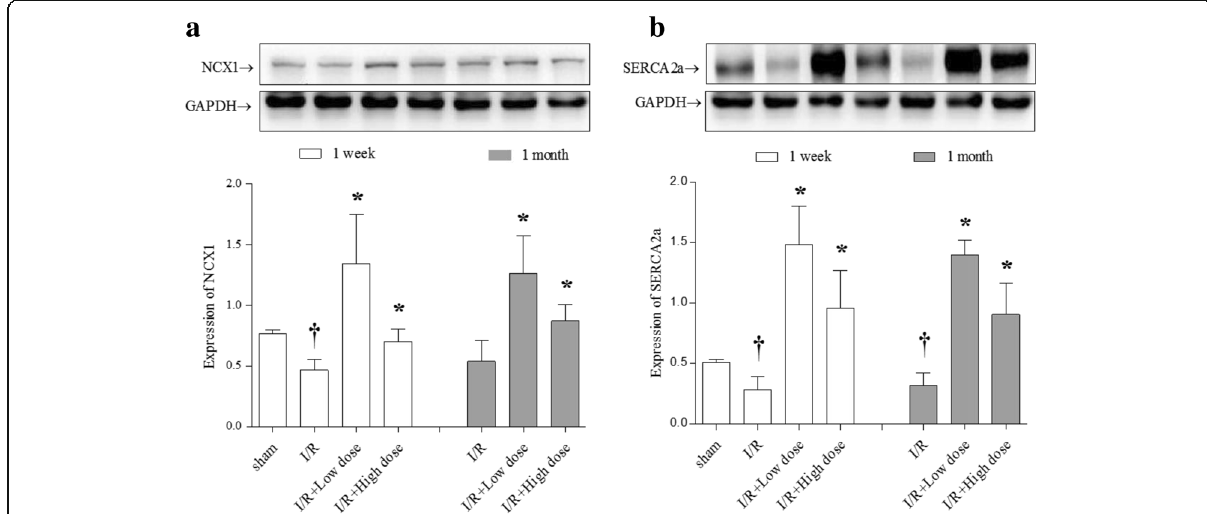
Fig. 3 Effects of MYQ on the expression of NCX1 and SERCA2a. a Expression of SERCA2a, upper is the representative blots of NCX1 and GAPDH; lower is the densitometric analysis of NCX1 expression normalized to GAPDH ( n = 8). b Expression of SERCA2a, upper is the representative blots of SERCA2a and GAPDH; lower is the densitometric analysis of SERCA2a expression normalized to GAPDH ( n = 8). Sham: Sham group; I/R: ischemic/reperfusion group. I/R + Low dose: Low dose (1 ml, P.O. tid for one-week or 1 month) MYQ treatment group. I/R + High dose: High dose (4 ml, P.O. tid for one-week or 1 month) MYQ treatment group. All data were expression as mean ± S.E.M. † P < 0.05 compared with sham group, * P < 0.05 compared with I/R group